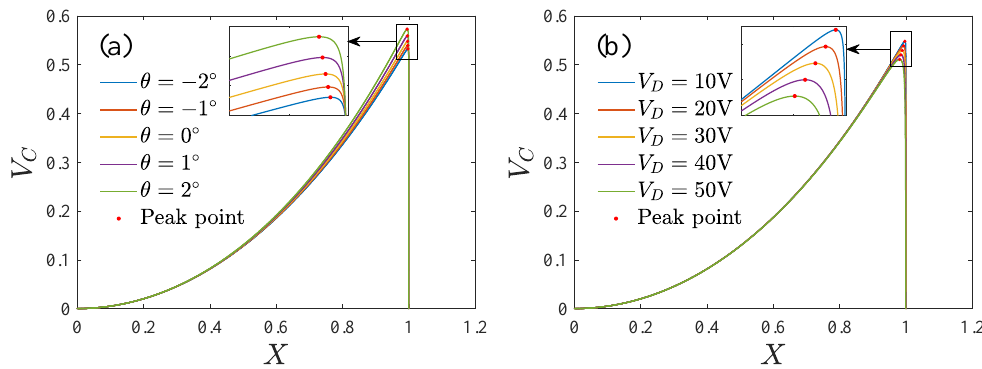
Figure 8. The potential energy in the driving direction, ( a ) The potential energy corresponding to different inclination angles, ( b ) The potential energy corresponding to different DC voltages.